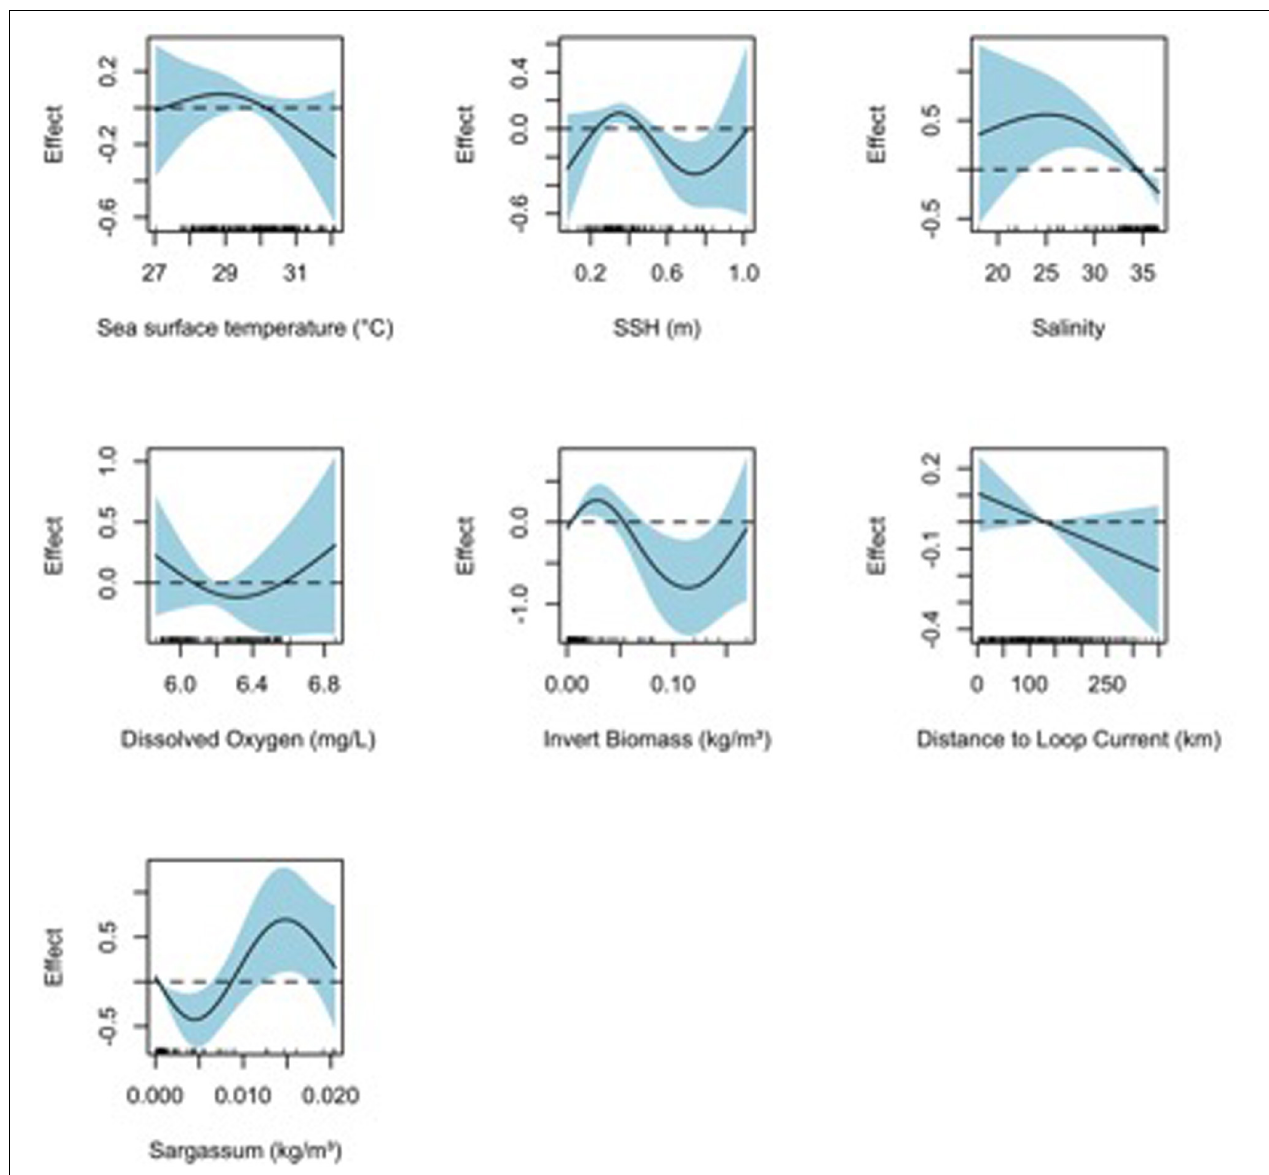
FIGURE 4 | Response plots for 2015 oceanographic variable of the surface sample (0–1 m with neuston tows) taxonomic richness ( T F ) from full generalized additive model (GAM). Plots include sea surface temperature ( ◦ C), sea surface height (m), salinity, dissolved oxygen (mg/L), invertebrate biomass (kg m − 3 ), distance to Loop Current (km), and Sargassum density (kg m − 3 ). Solid lines represent smoothed values and the shaded area represents 95% confidence intervals. Dashed line displayed at y = 0 on response